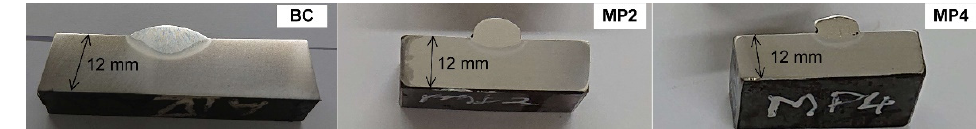
Figure 2. Photograph images of weld metal cross sections of BC, MP2, and MP4 weld metal. The dilution ratio percentage, incorporating the metal powder contribution to the weld metal as (%DR (wire+MP) ) is calculated as shown in Equation (7) [34]. This method is similar to the literature reported method applied in the case of weld wire and base plate used in bead-on-plate SAW [30,34]. In this method, the weld metal cross section area extending above the base plate level represents the proportion contribution of weld wire to the total weld metal mass. When metal powders and weld wire are added into the weld metal, the weld metal cross section area extending above the base plate level represents the proportion contribution of both, the metal powder, and the weld wire, to the total weld metal mass. The mass of Al, Cr, and Cu added to the weld metal was calculated from Equations (7)–(9), using the weld metal composition in Table 3 as input to Equation (9).